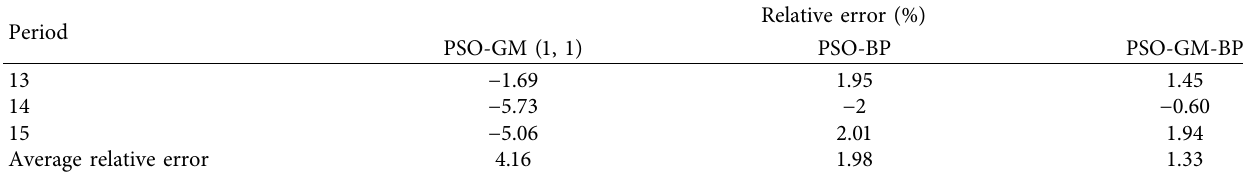
Table 9: Comparison of relative error of three models.